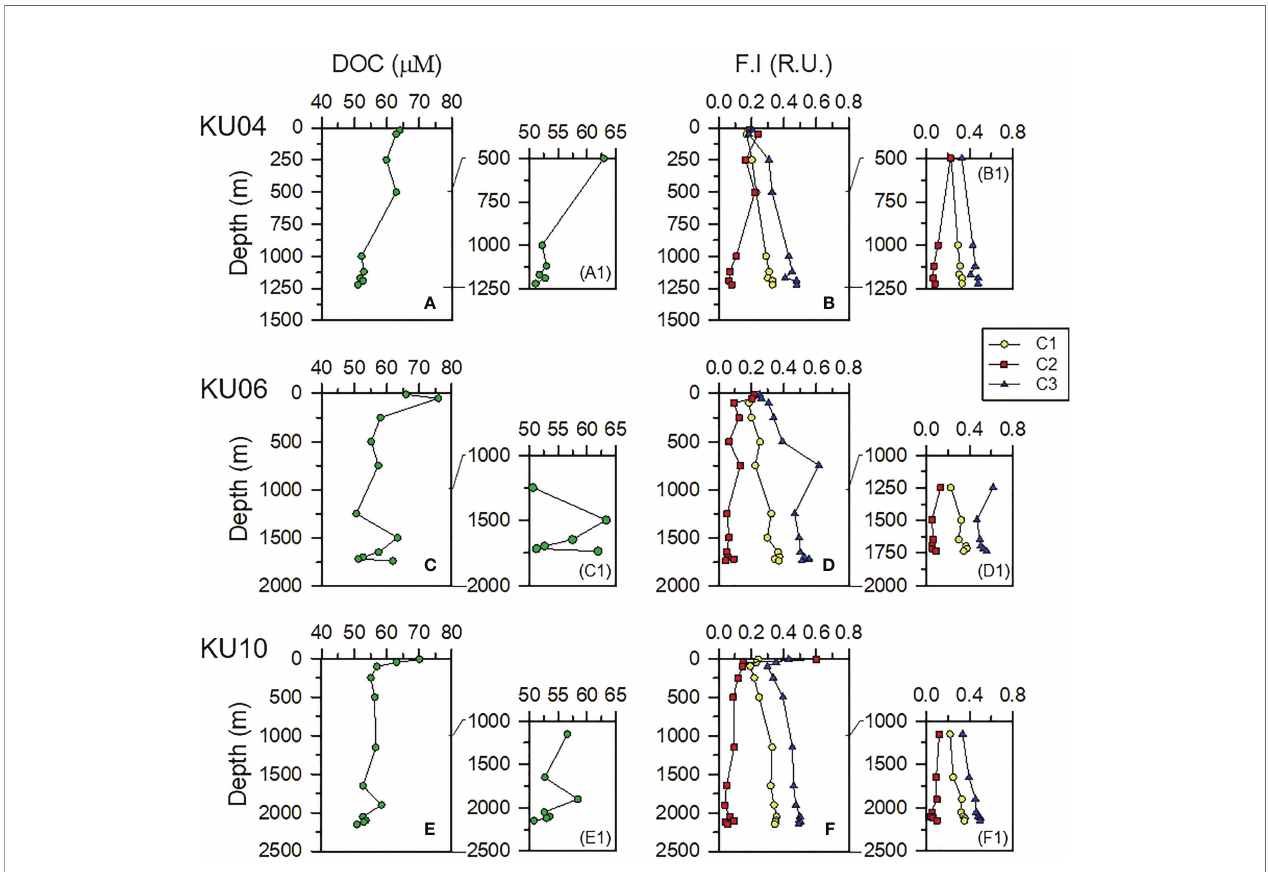
FIGURE 2 | Vertical distribution of dissolved organic carbon (DOC; A – E1 ) and fl uorescence intensity (F.I., B – F1 ) of the three components ( C1, C2 and C3 ) de fi ned as fl uorescent dissolved organic matter (FDOM) in the water column of the